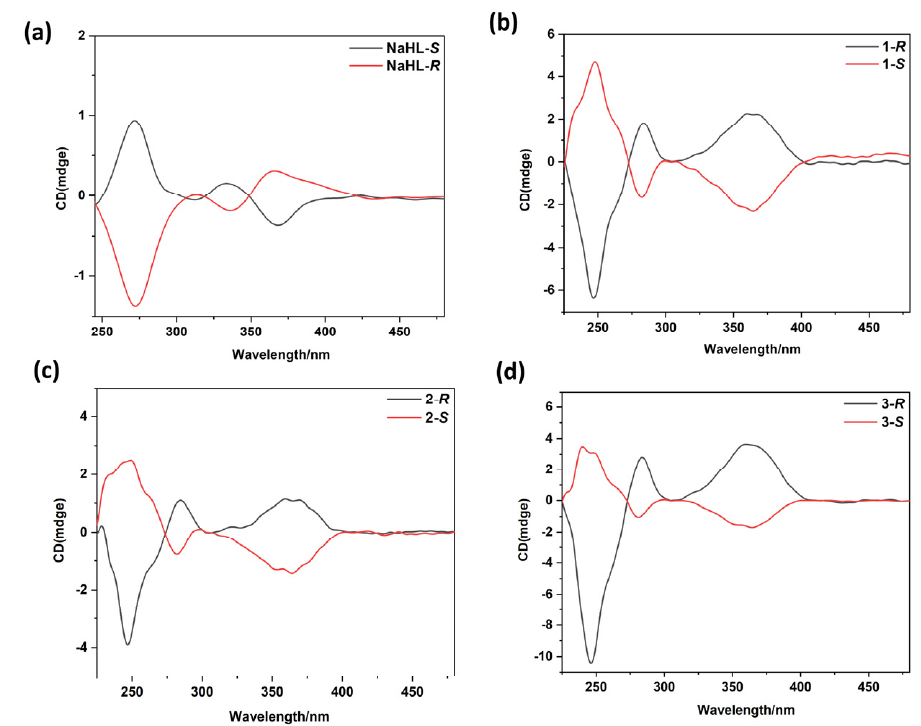
Figure 6. ( a ) CD spectra of NaHL in methanol with the concentration of 2.5 × 10 − 5 mol L − 1 . ( b ) CD spectra of 1- S and 1- R in methanol with the concentration of 2.5 × 10 − 5 mol L − 1 . ( c ) CD spectra of 2 - S and 2- R in methanol with the concentration of 2.5 × 10 − 5 mol L − 1 . ( d ) CD spectra of 3- S and 3 - R in methanol with the concentration of 2.5 × 10 − 5 mol L − 1 .